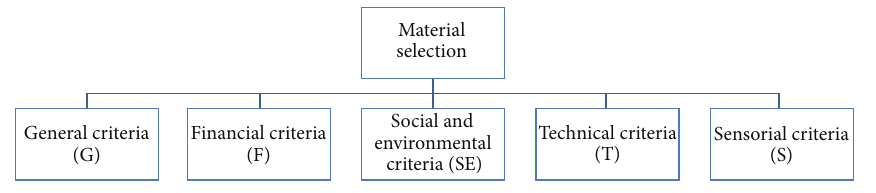
Figure 3: Main influencing criteria in material